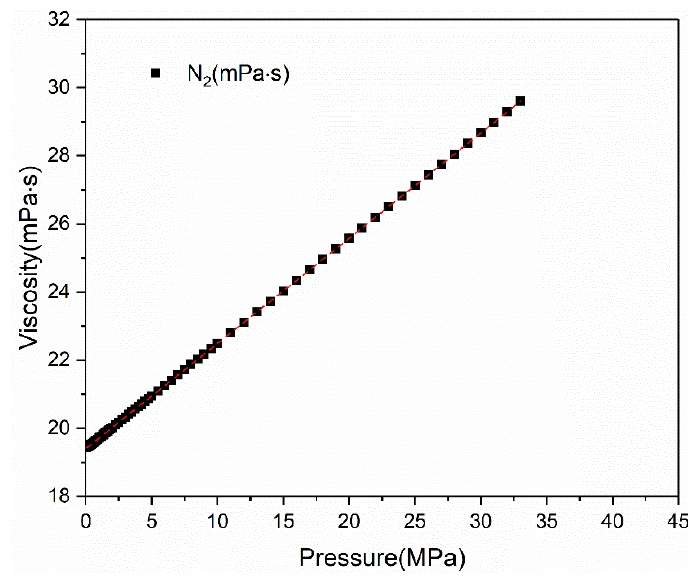
Figure 1. Viscosity of nitrogen as a function of pressure.